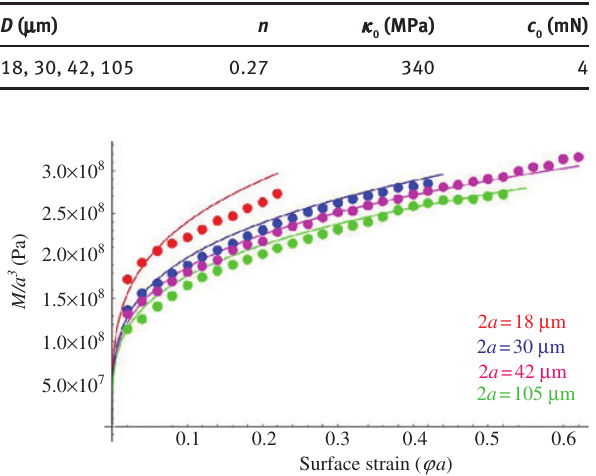
Table 1: Parameter values for modeling torsion experimental data [10] using Eq.